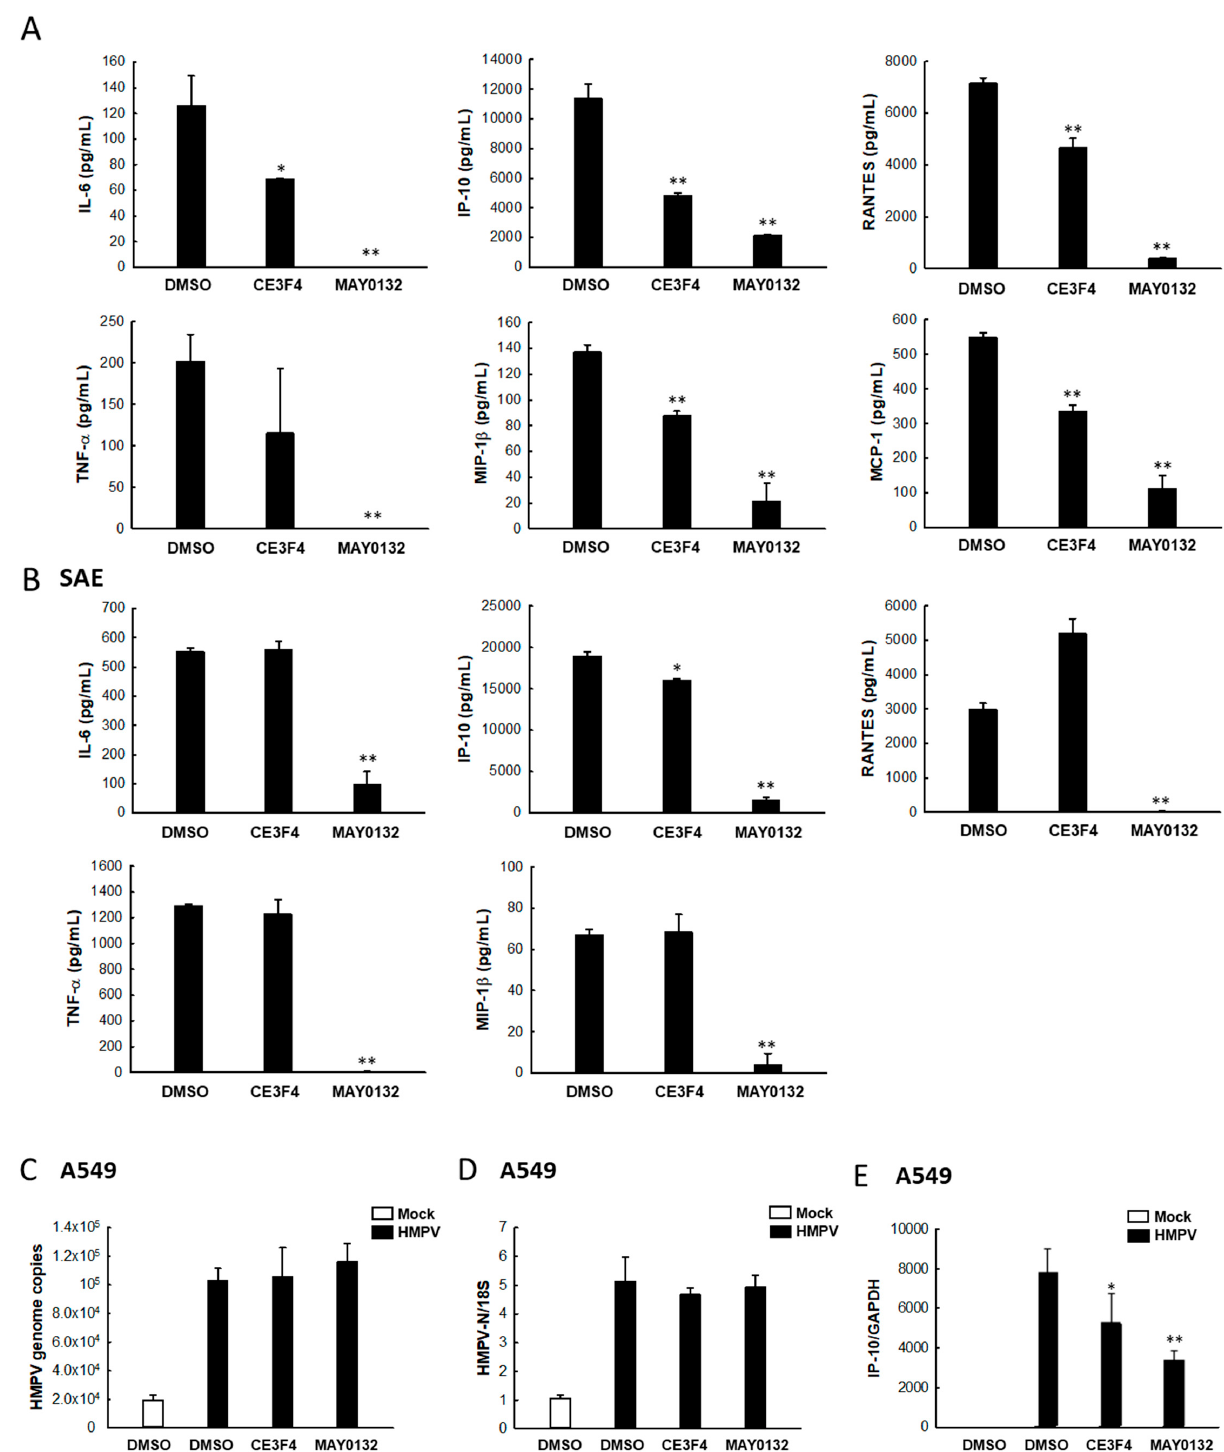
Figure 2. EPAC2-mediated cytokine/chemokine induction by HMPV. ( A,B ) A549 ( A ) or SAE ( B ) cells in triplicate were infected with HMPV at an MOI of 1. At 2 h p.i., cells were treated with DMSO, 20 μ M CE3F4, or 20 μ M MAY0132. At 15 h post-treatment, the supernatant was collected, and the amount of diluted or undiluted cytokines/chemokines was measured by Bio-Plex. * p < 0.05 and ** p < 0.01, relative to the DMSO-treated group. ( C – E ) A549 cells in triplicate were infected with HMPV, followed by the drug treatment as described in ( A ). At 4 h post-treatment, total RNA was extracted and subjected to qRT-PCR to measure HMPV genome copies ( C ), N gene expression ( D ), and IP-10 production ( E ). DMSO-treated mock infection was used as a negative control for DMSO-treated HMPV infection. * p < 0.05 and ** p < 0.01, relative to the DMSO-treated and HMPV-infected